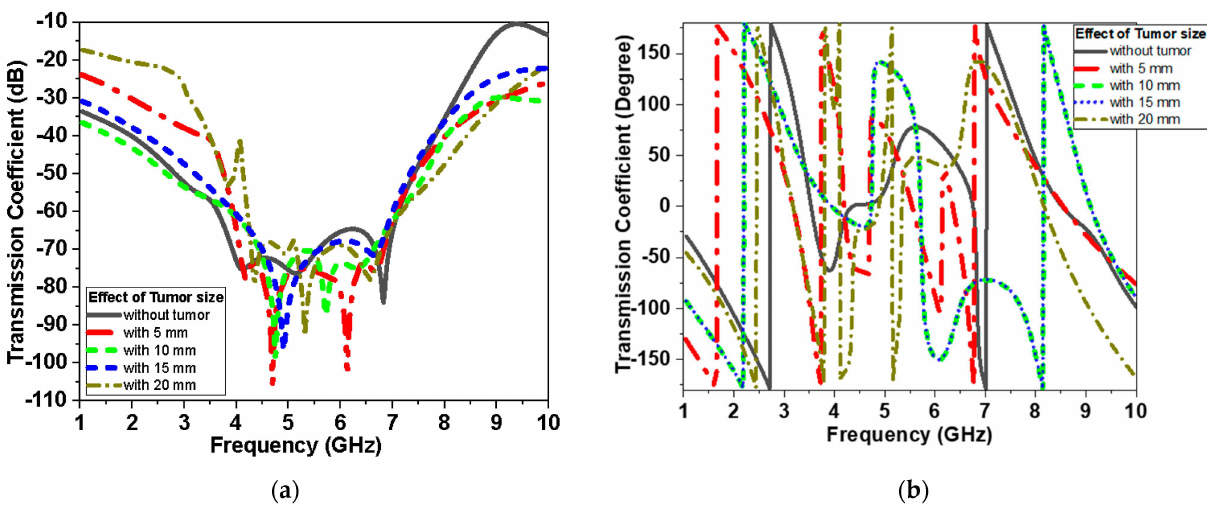
Figure 17. Simulated |S 21 | of proposed monopole antenna with and without tumor (second scenario shown in in Figure 14b) at different sizes of tumor: ( a ) |S 21 | magnitude in dB and ( b ) |S 21 |phase in degrees.